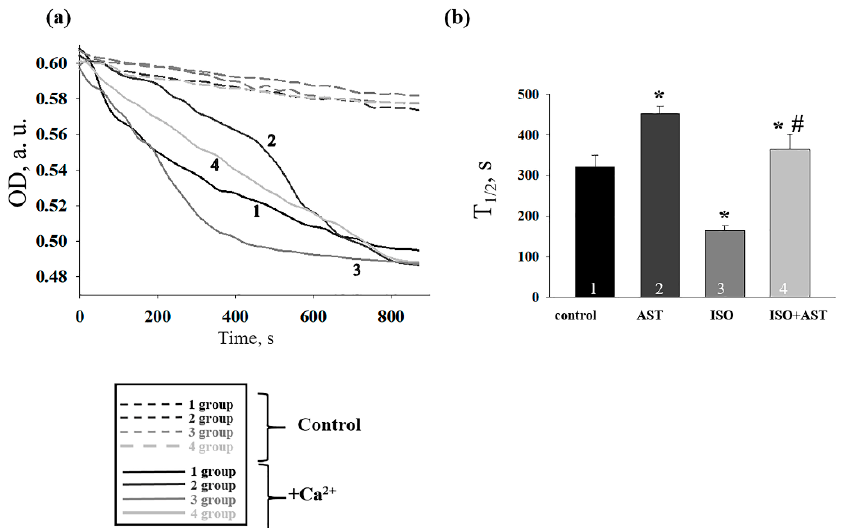
Figure 4. The effect of the administration of AST and ISO on the swelling of RBM. ( a ) Curves of swelling of RBM isolated from rats of each group; ( b ) the half-maximum value of mitochondrial swelling (T 1/2 ). The data are presented as the means ± SDs of six independent experiments. * p < 0.05 indicates a significant difference in mitochondrial swelling relative to the control (group 1). # p < 0.05 a significant difference compared with ISO alone (group 3).